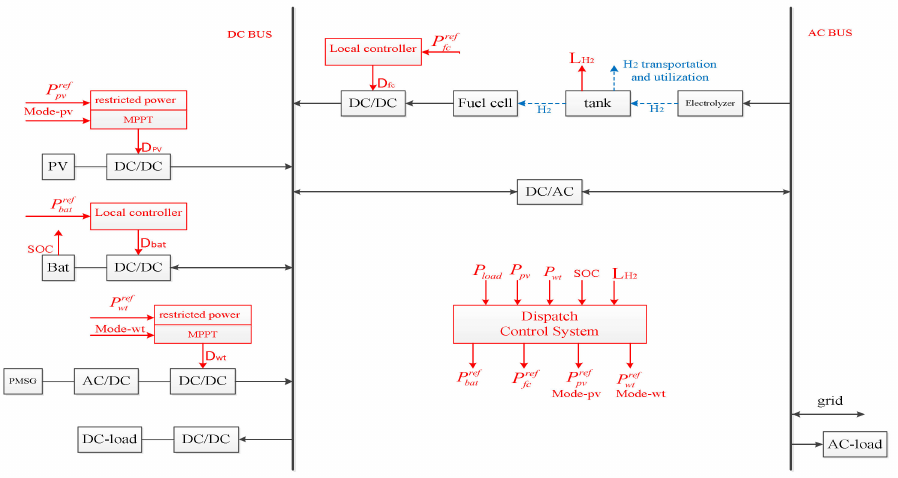
Figure 1. Topology of multi-energy integrated